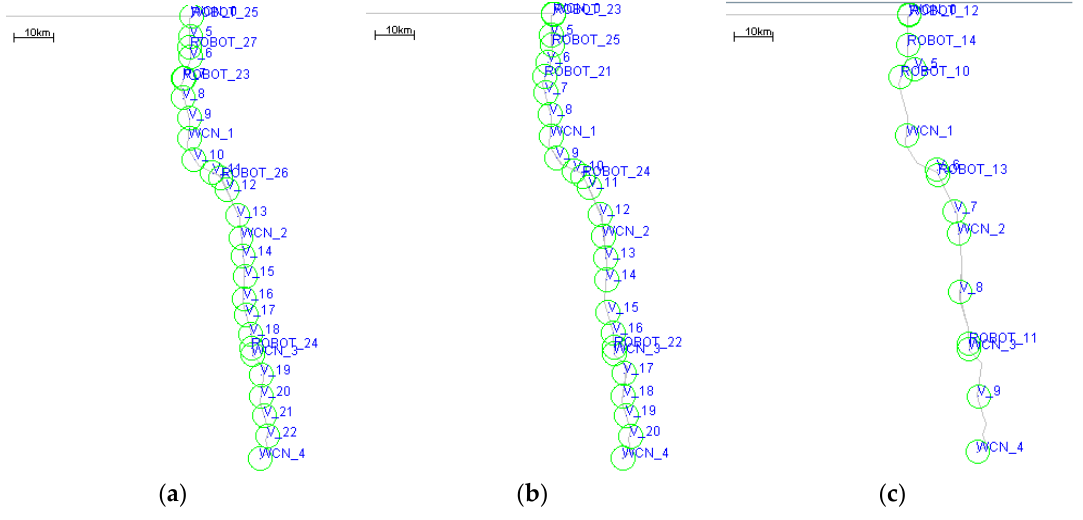
Figure 9. Nodes deployment diagram with different α . ( a ) α = 0.9; ( b ) α = 0.5; ( c ) α = 0.3.